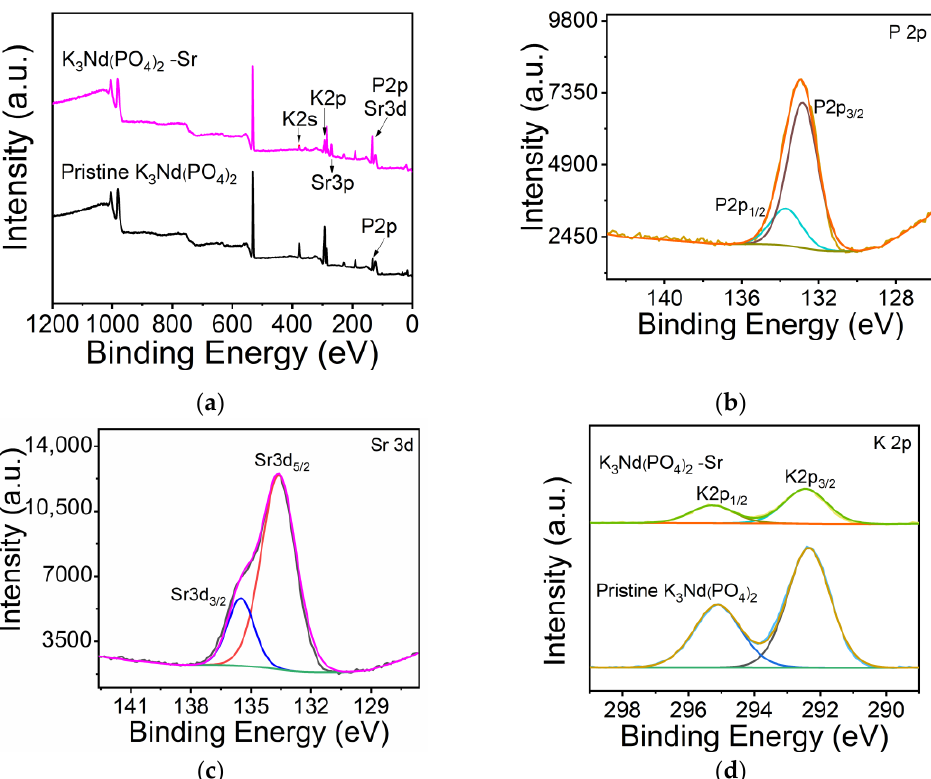
Figure 5. ( a ) XPS survey spectra of the pristine K 3 Nd(PO 4 ) 2 and the adsorption product K 3 Nd(PO 4 ) 2 -Sr; ( b ) high-resolution XPS spectra of P2p for the pristine K 3 Nd(PO 4 ) 2 ; ( c ) high-resolution XPS spectra of Sr3d for the adsorption product K 3 Nd(PO 4 ) 2 -Sr; ( d ) high-resolution XPS spectra of K2p for the pristine K 3 Nd(PO 4 ) 2 and the adsorption product K 3 Nd(PO 4 ) 2 -Sr.